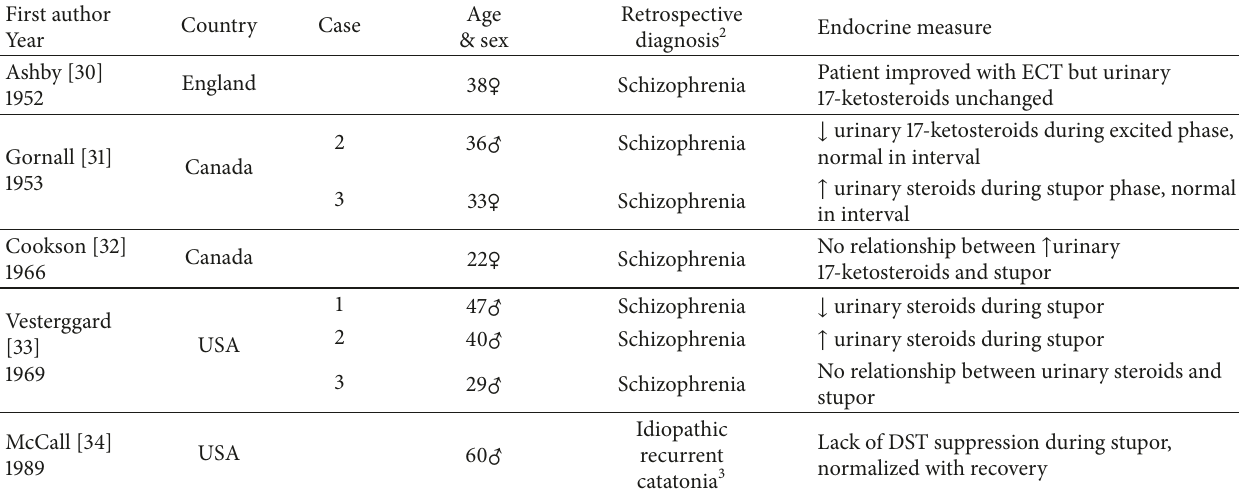
Table 1: Adrenal abnormalities in 8 published patients with periodic catatonia 1